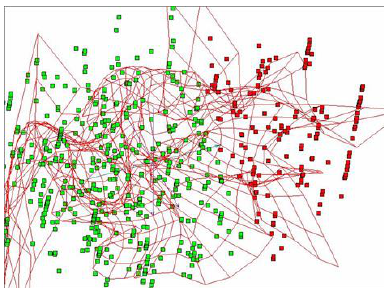
Figure 13. Elastic map for 12-dimensional attribute space when diagnosing ASD